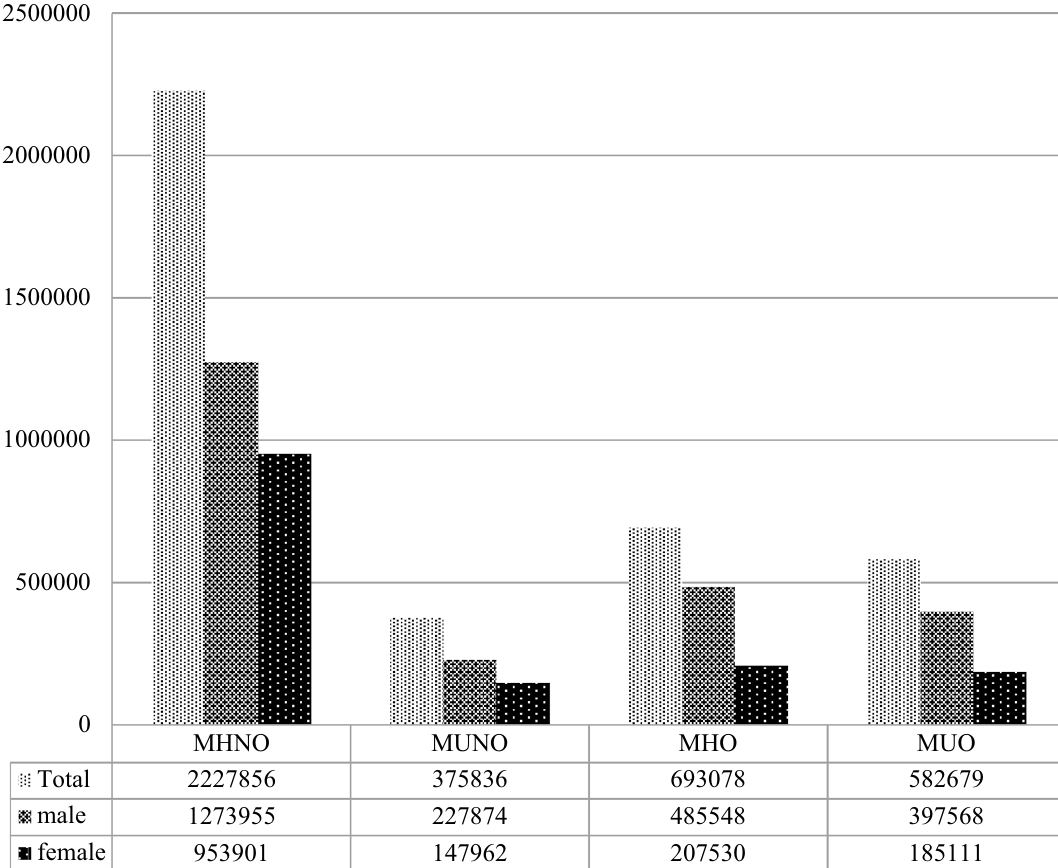
Figure 1. Distribution of study population according to BMI and metabolic health status. Of the 3,879,449 participants, 2,227,856 (57.4%), 375,836 (9.7%), 693,078(17.9%) and 582,679 (15.0%) subjects were classified as having the MHNO, MUNO, MHO, and MUO phenotypes,